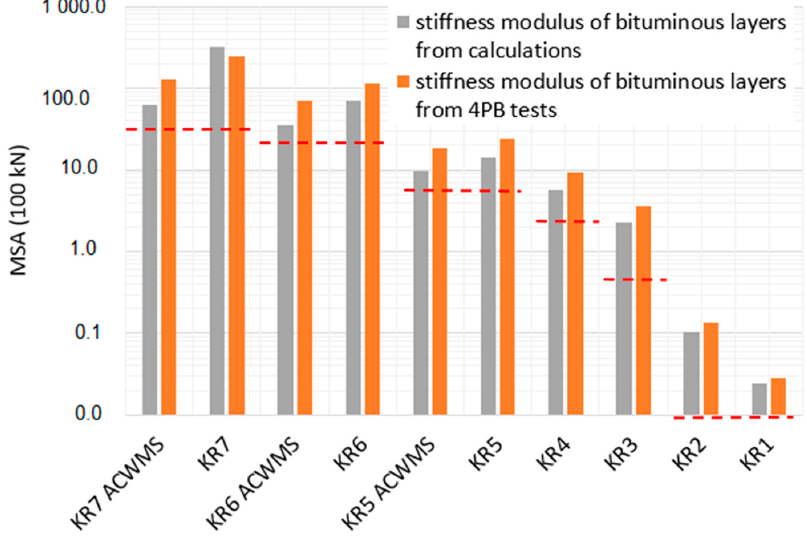
Figure 9. Results of calculations of pavement structure according to the French method for asphalt courses.